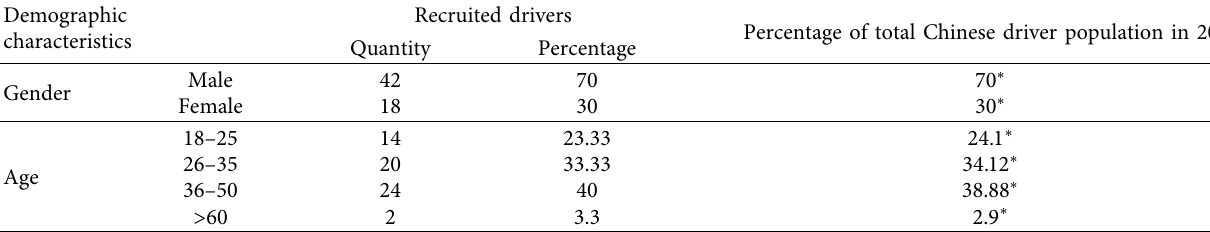
Table 1: Demographic characteristics of participants.